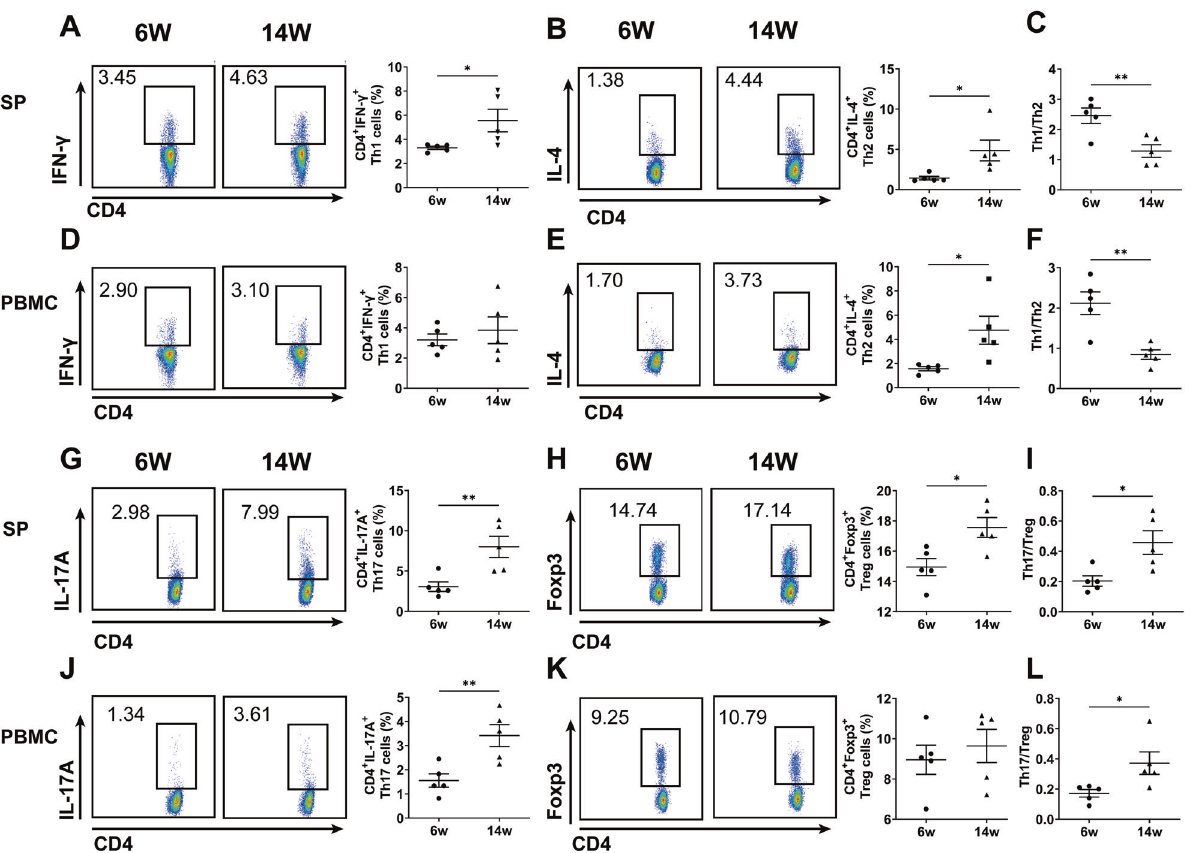
Fig. 7 Th1/Th2 and Th17/Treg were imbalanced in SS-like NOD mice. CD4 + IFN- γ + Th1 cells, CD4 + IL-4 + Th2 cells, CD4 + IL-17A + Th17 cells and CD4 + Foxp3 + Treg cells in SP and PBMC from 6 and 14-week-old NOD mice were detected by fl ow cytometry. Representative fl ow cytometric analysis and percentages of CD4 + T cell subsets were shown. A Th1 cells in SP, B Th2 cells in SP, C the ratio of Th1/Th2 in SP, D Th1 cells in PBMC, E Th2 cells in PBMC, F the ratio of Th1/Th2 in PBMC, G Th17 cells in SP, H Treg cells in SP, I the ratio of Th17/Treg in SP, J Th17 cells in PBMC, K Treg cells in PBMC, L the ratio of Th17/Treg in PBMC. All the data are representative of two independent experiments. n = 5, * p < 0.05, ** p <